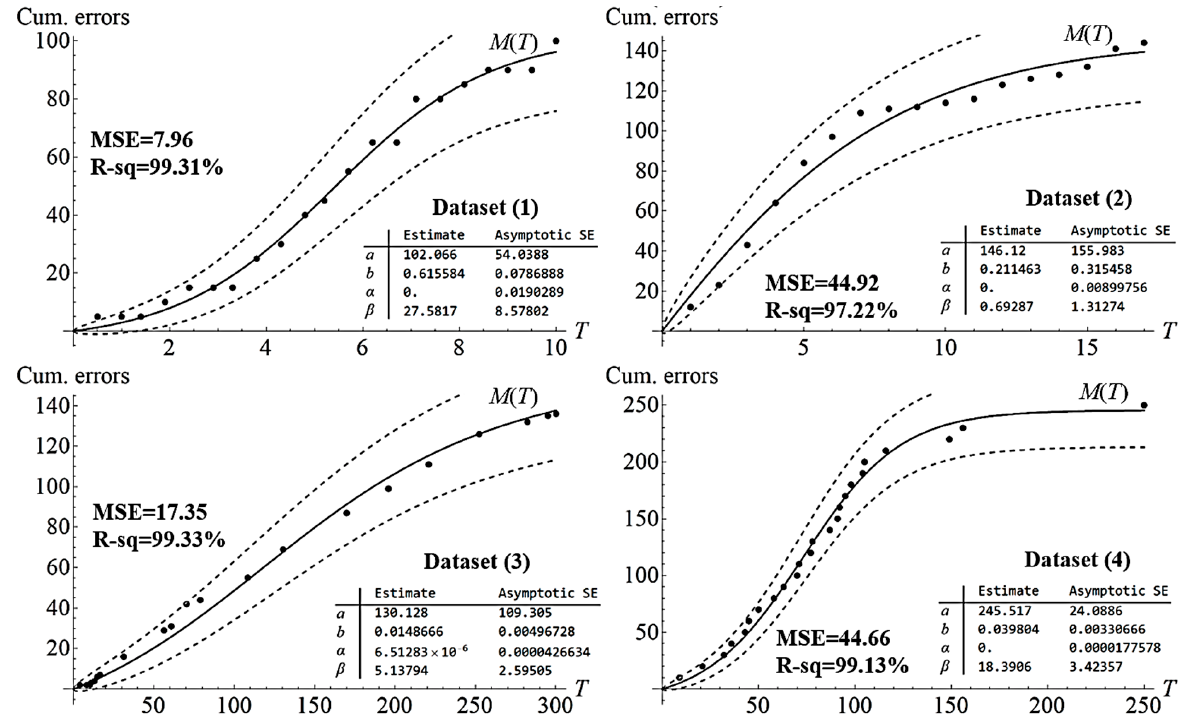
Figure 2. The fitting results and parameter estimation for Pham’s model.